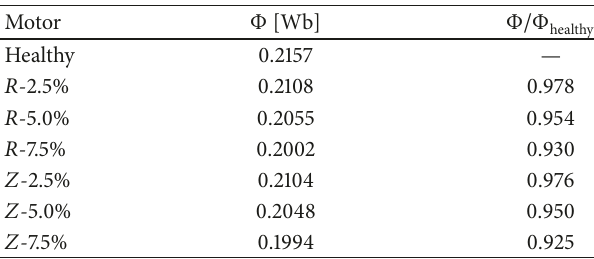
Table 2: Measured flux